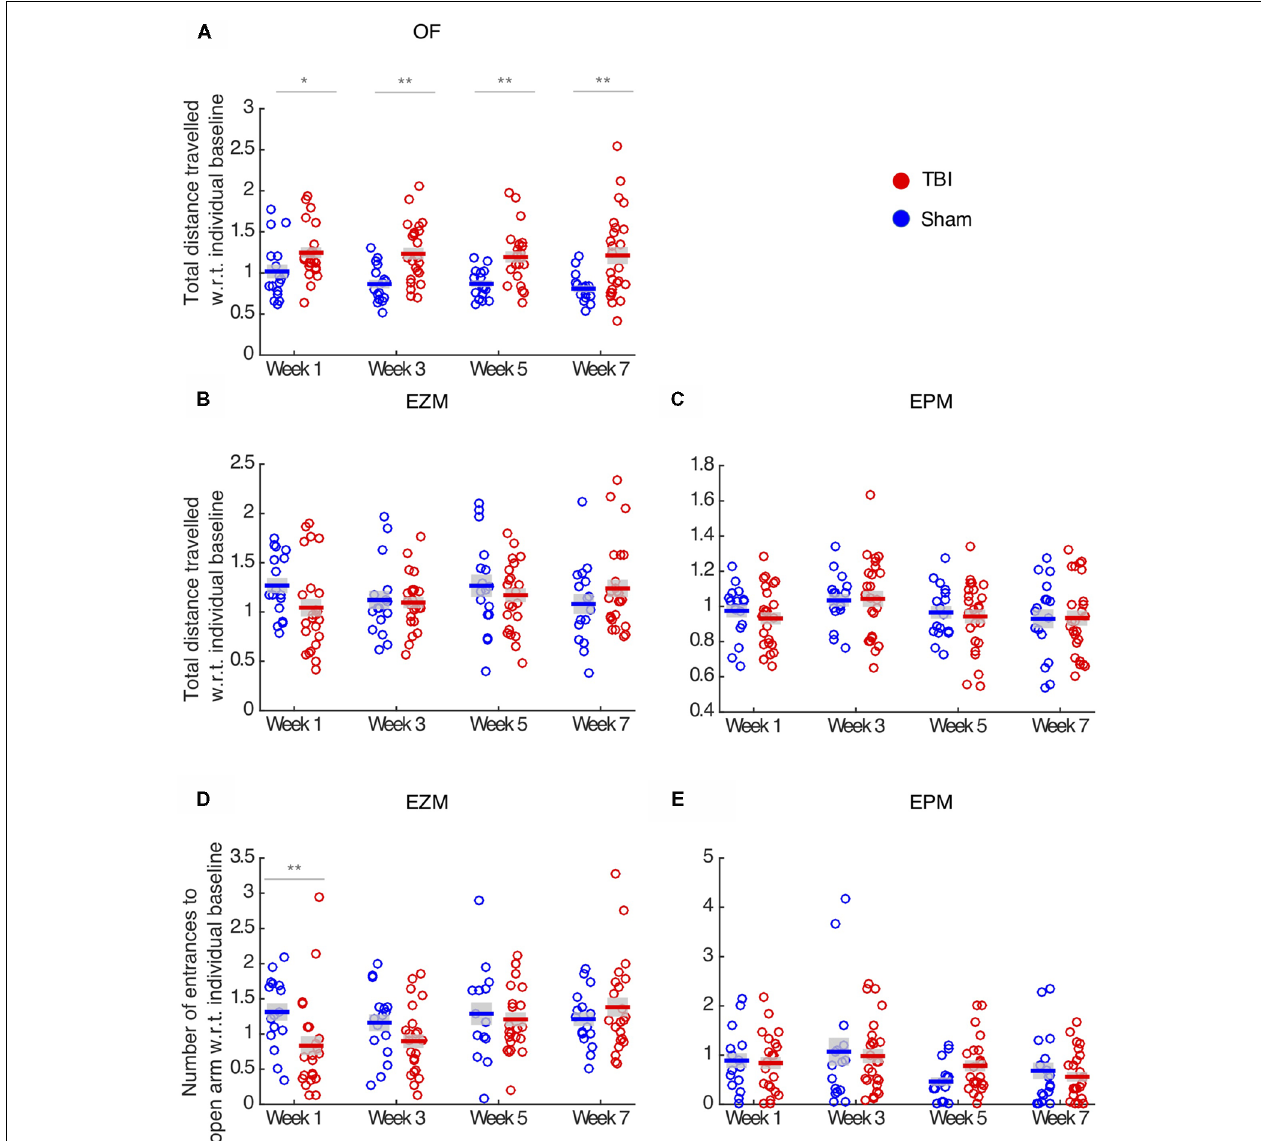
FIGURE 2 | TBI effects vary across behavioral assays and metrics. (A) Total distance traveled in the OF. There is a main effect of injury (repeated two-way ANOVA, p < 0.01), and TBI animals travel more at all time-points compared to sham controls. (B,C) Total distance traveled in the EZM and EPM, respectively. There is no effect of injury in locomotion in these assays. (D) Number of entrance to the open arm in the EZM. There is a main effect of injury (repeated two-way ANOVA, p < 0.05) and TBI animals present fewer entrance on week 1 than sham controls. (E) Number of entrances to the open arm in the EPM. There is no effect of injury. In all panels, each circle represents one mouse. Horizontal bars denote means; shaded regions denote SEM. Data from n = 25 mice in TBI condition, and n = 17 mice in sham condition are shown after removal of outliers at each time point (“Materials and Methods” section); the number of outliers at any time point for any condition did not exceed three mice; ∗ p < 0.05, ∗∗ p <